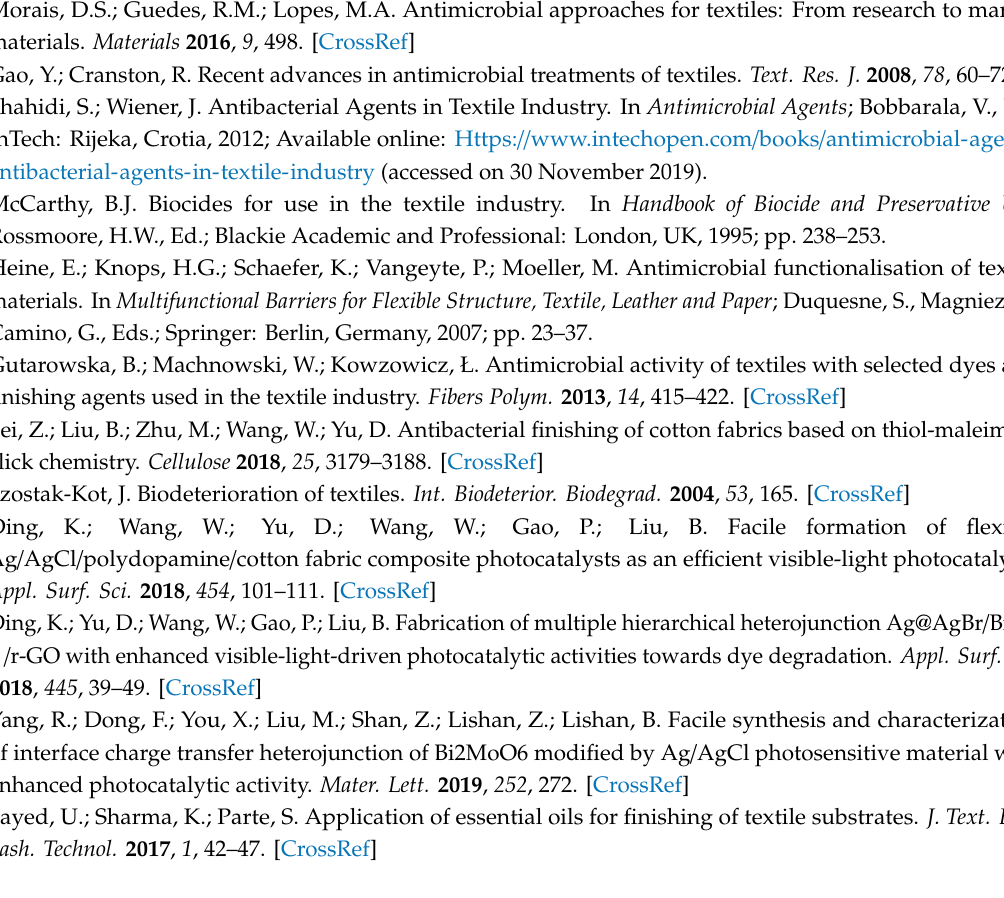
Table S1: Putative identification of metabolites in beeswax based on Lipid Maps